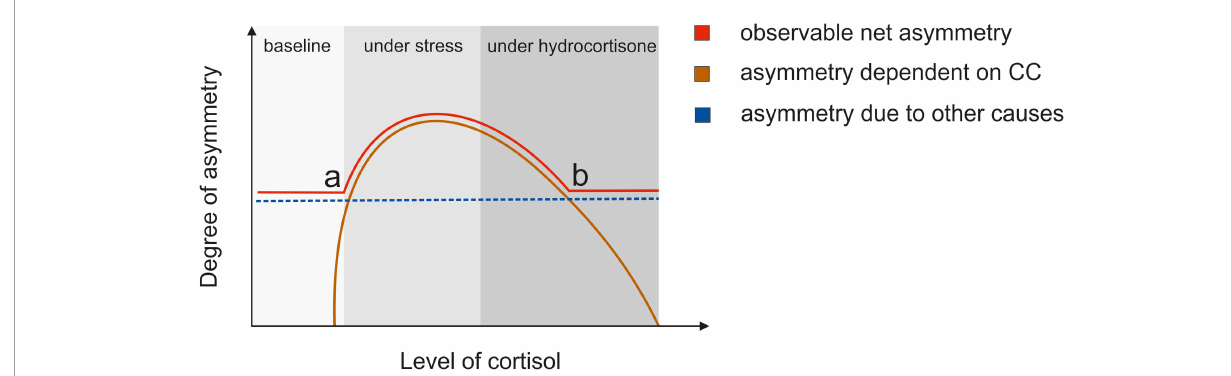
FIGURE8 The hypothesized relationship between the degree of interhemispheric integration and level of cortisol. This model assumes that interhemispheric integration of information and functional hemispheric asymmetries can be seen as two sides of the same coin akin to assumptions made by Bayer et al. (21). The blue line indicates the level of asymmetry that is dependent on other factors than the corpus callosum, e.g., hemispheric specialization. This degree of asymmetry is constant and independent of levels of circulating hormones. The orange line indicates the degree of interhemispheric integration that depends on the corpus callosum, which can be influenced by changing hormone levels. If the cortisol level rises due to stress, the membrane MR receptors are partially occupied leading to a higher degree of integration. This leads to the apex in the curve. If cortisol levels are higher due to pharmacological administration of hydrocortisone, GR receptors are saturated. The red line indicates the observable degree of interhemispheric integration. At (a) the Integration rises due to rising cortisol levels improving callosal function. At (b) while the integration of information through the corpus callosum decreases due to high cortisol levels, the net integration levels out at the baseline degree of asymmetry that stays